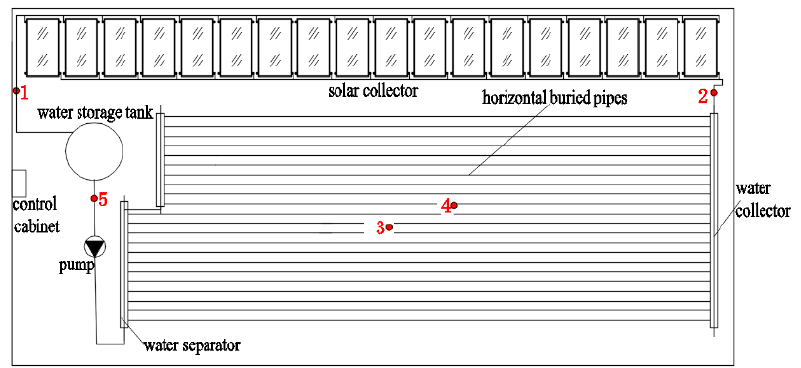
Figure 9. Schematic diagram of measuring point locations. (1. outlet water temperature of collector, 2. inlet water temperature of collector, 3. soil temperature at 15 cm and 30 cm depths, 4. indoor environmental parameters, 5. outlet temperature of water storage tank.).